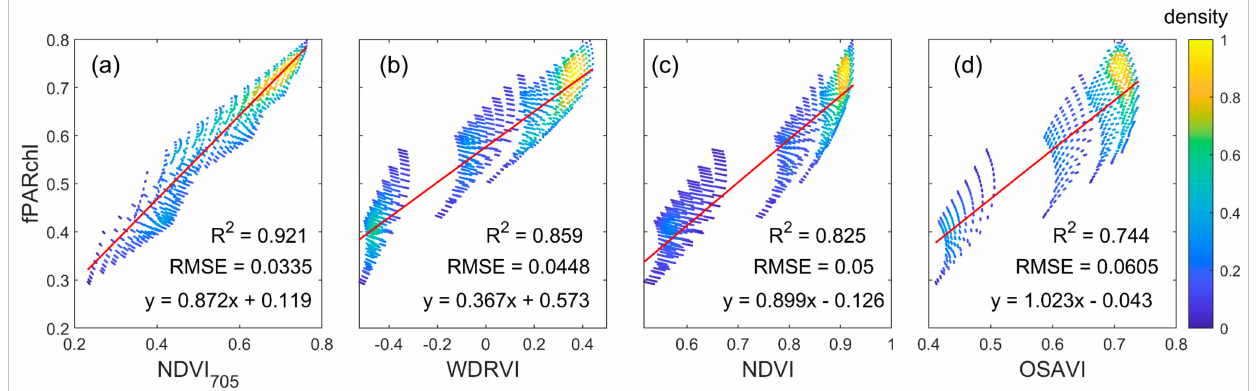
Figure 2. Linear regressions of the fPARchl on the different VIs computed from SCOPE 2.0